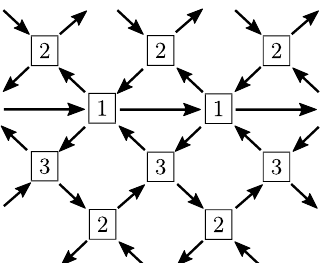
. We can determine it from the quiver diagram and Q 2 | 1 to be a loop on the periodic quiver. In this example, Q 2